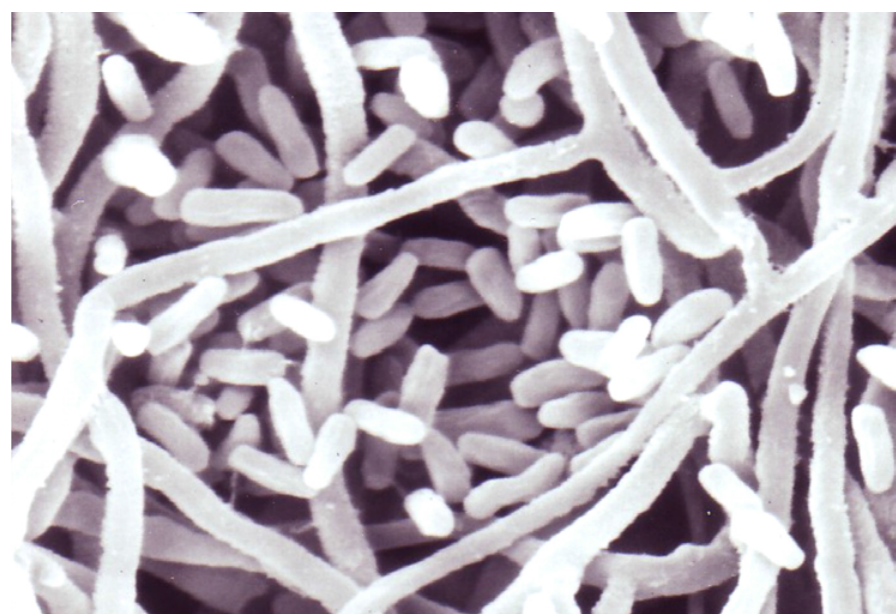
Fig. 5. Conidia of Phoma negriana (SEM), 4300 x magnification. Phot. M.